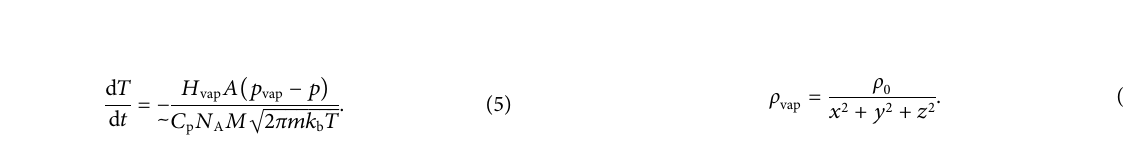
FIGURE 7 (A) before and (B) after images of catastrophic freezing in a jet of DMSO. The ice grows to this size in less than a